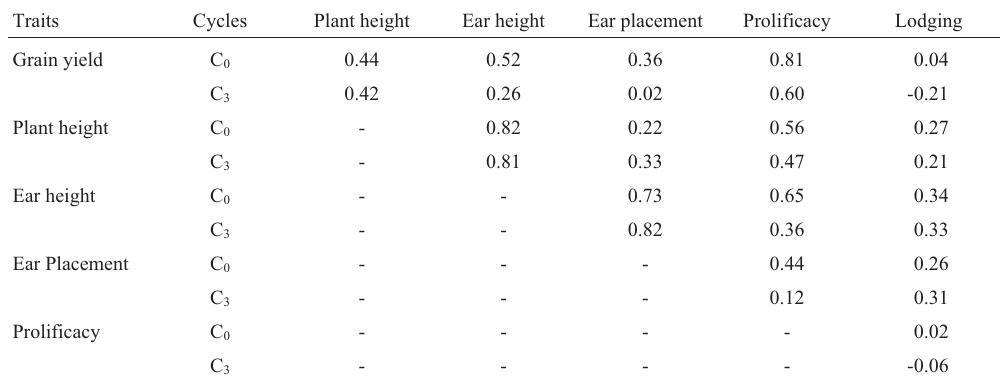
0 ) and after three cycles (C 3 ) of reciprocal recurrent selection.